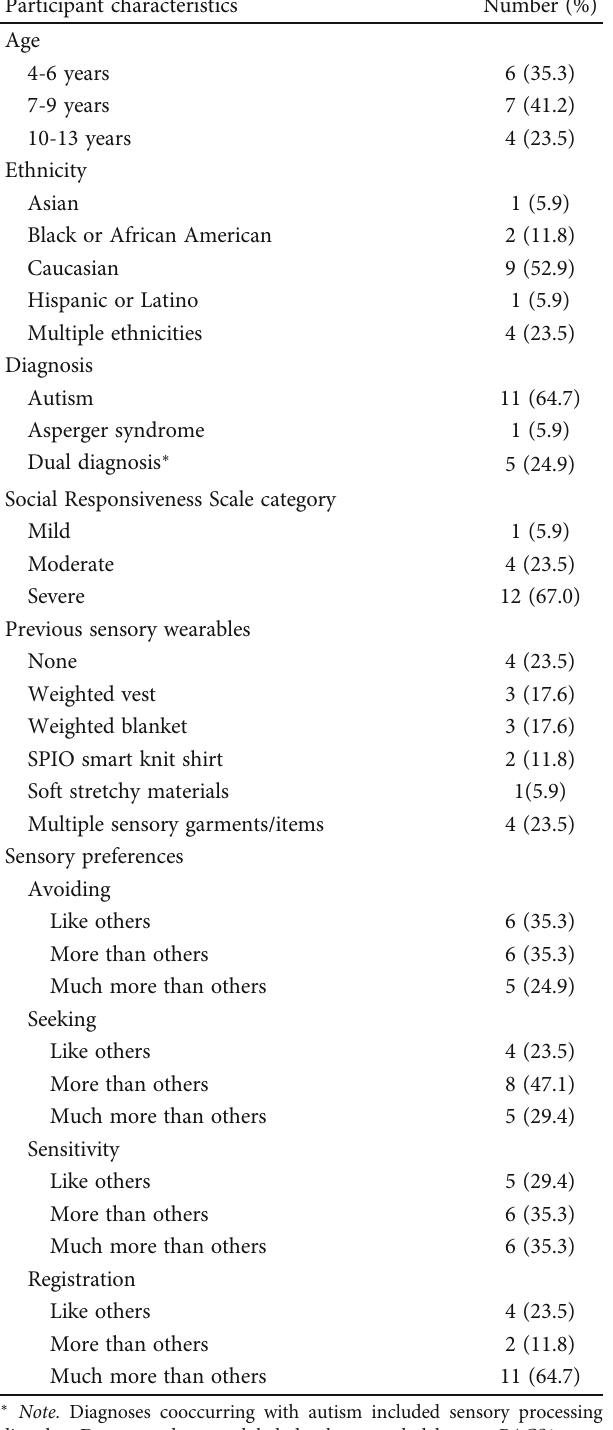
Table 2: Participant demographics. Table 3: COPM performance and satisfaction score di ff erences by